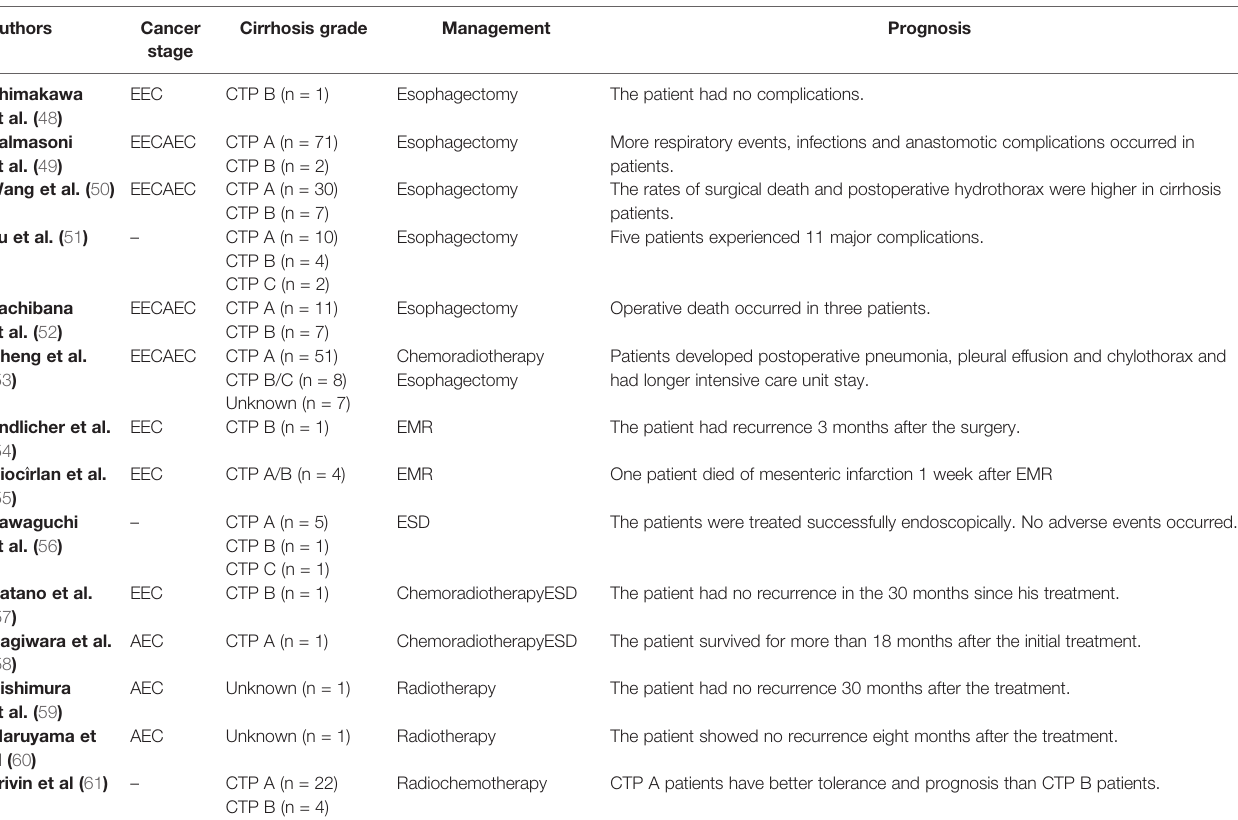
TABLE 2 | Summary of esophageal cancer stage, cirrhosis grade, surgical choice and